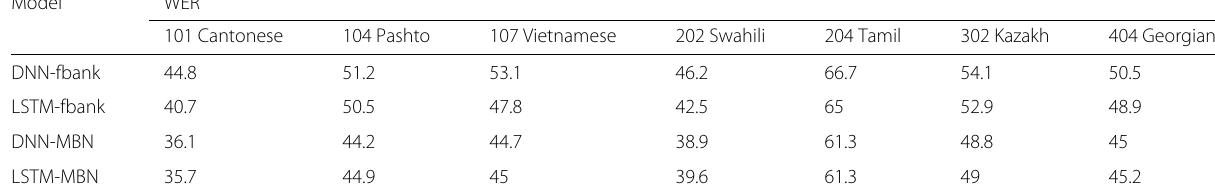
Table 3 WER (%) of the baseline models for all languages